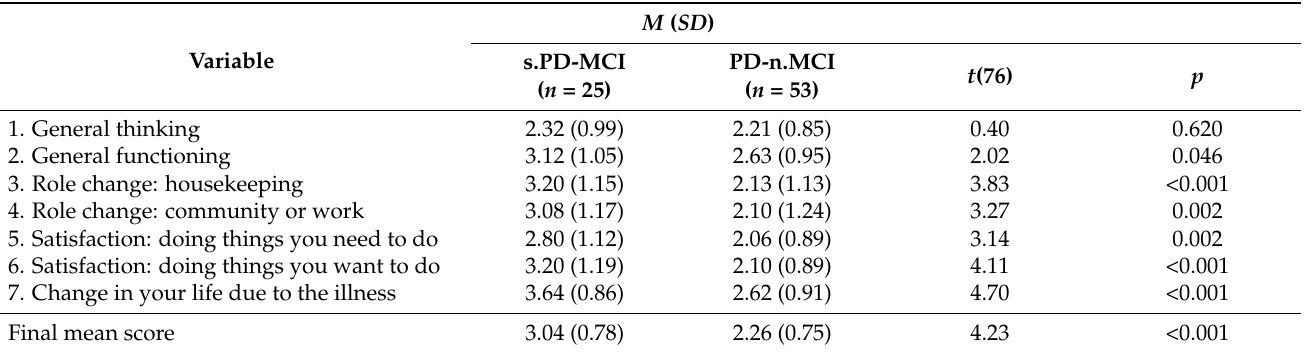
Table 1. Comparison of the item and mean final scores of the perceived general functional ability of s.PD-MCI and PD-n.MCI patients.